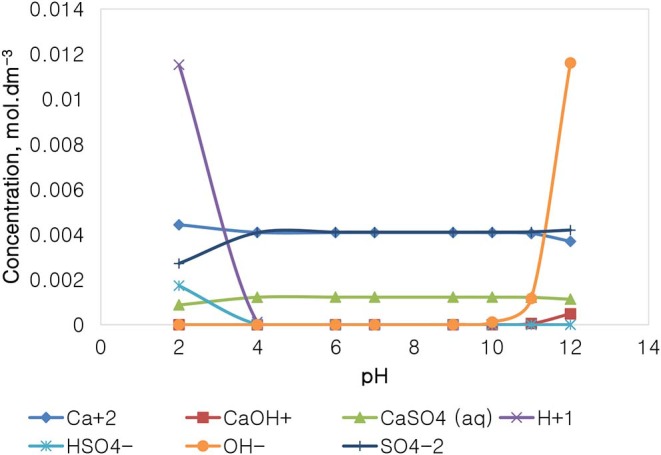
CaSO4 speciation for a solution of 0.0213 mol dm−3 ionic strength.